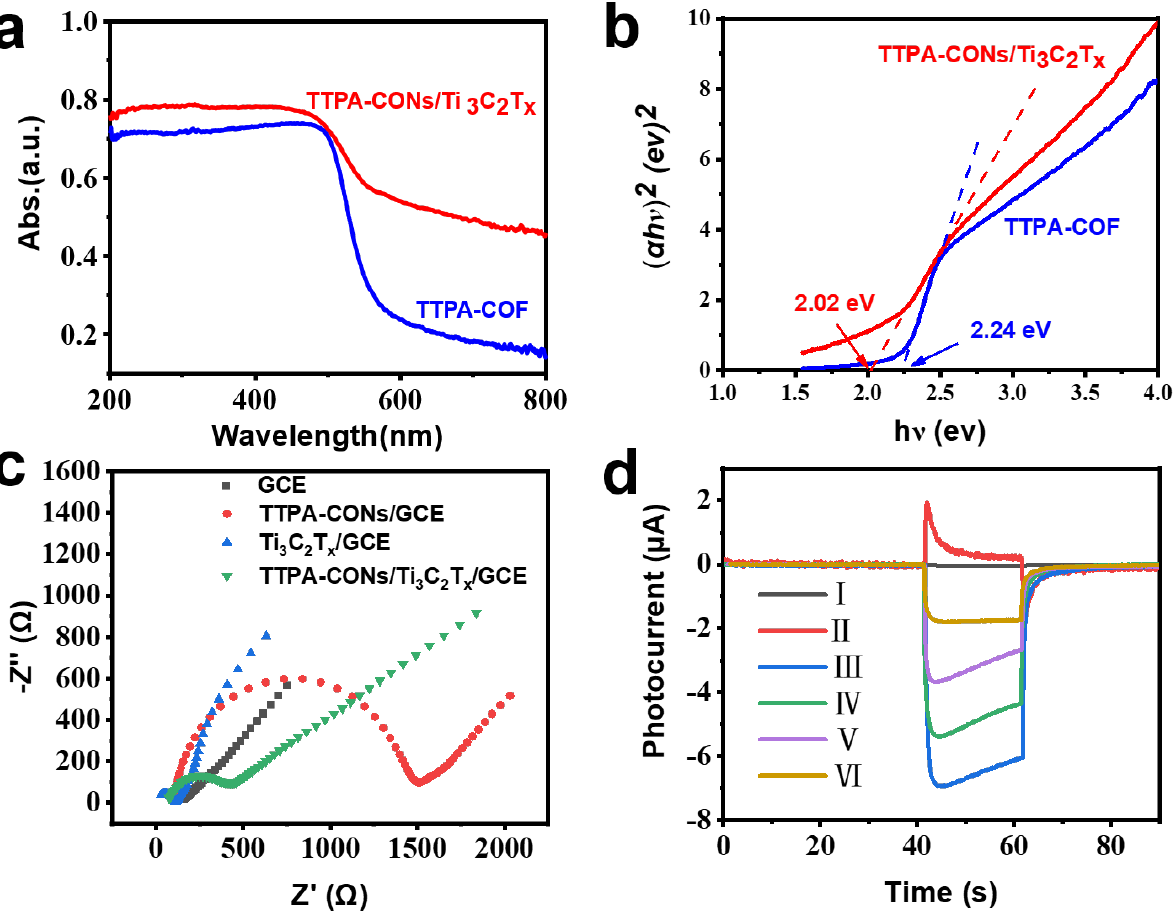
Figure 3. ( a , b ) UV – vis DRS spectra ( a ) and Tauc’s plots ( b ) of TTPA − COF and TTPA − CONs/Ti 3 C 2 T x . ( c ) EIS plots of GCE, TTPA − CONs/GCE, Ti 3 C 2 T x /GCE, and TTPA-CONs/Ti 3 C 2 T x /GCE. ( d ) Photocurrent responses of modified electrodes recorded at a bias potential of 0 V: ( Ⅰ ) TTPA − CONs/GCE, ( Ⅱ ) Ti 3 C 2 T x /GCE, ( Ⅲ ) TTPA − CONs/Ti 3 C 2 T x /GCE, ( Ⅳ ) Aptamer/TTPA − CONs/Ti 3 C 2 T x /GCE, ( Ⅴ ) BSA/Aptamer/TTPA − CONs/Ti 3 C 2 T x /GCE, and ( Ⅵ ) PSA/BSA/Aptamer/TTPA − CONs/Ti 3 C 2 T x /GCE. The PSA concentration used in ( Ⅵ ) was 10 ng/mL.